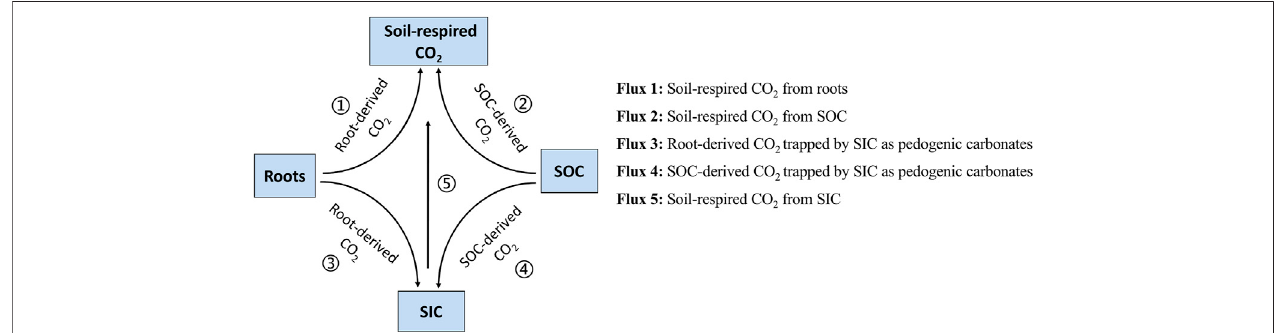
FIGURE 1 | Model for the different sources of CO 2 fl uxes from carbonate-rich soils with